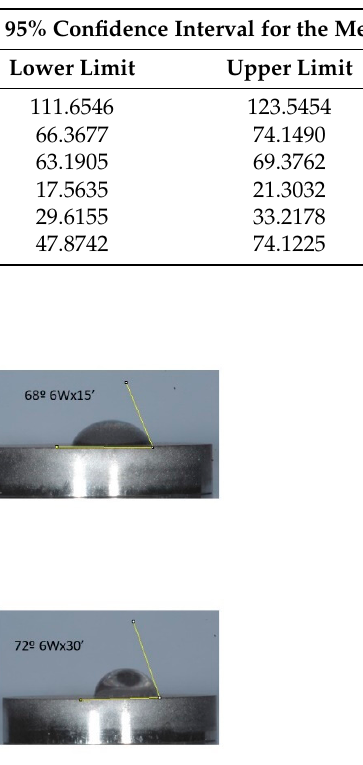
Figure 4. Composition of the different angles obtained with irradiation at 6 W for different time intervals compared with the control.